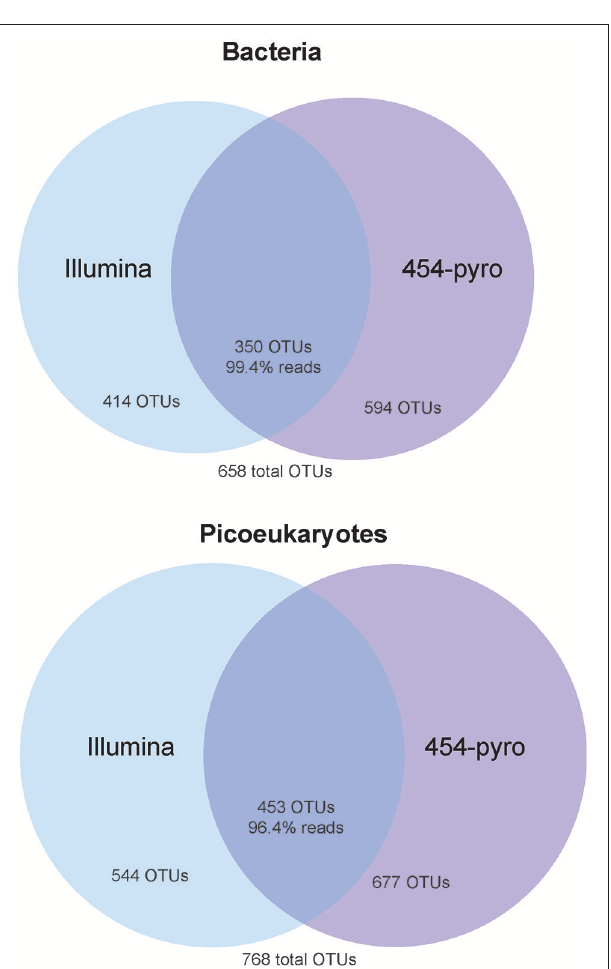
FIGURE 2 | Venn diagrams showing the extent of overlapping and platform-specific OTUs between the 454 and Illumina datasets applied to the bacterial (top) and picoeukaryotic (bottom)